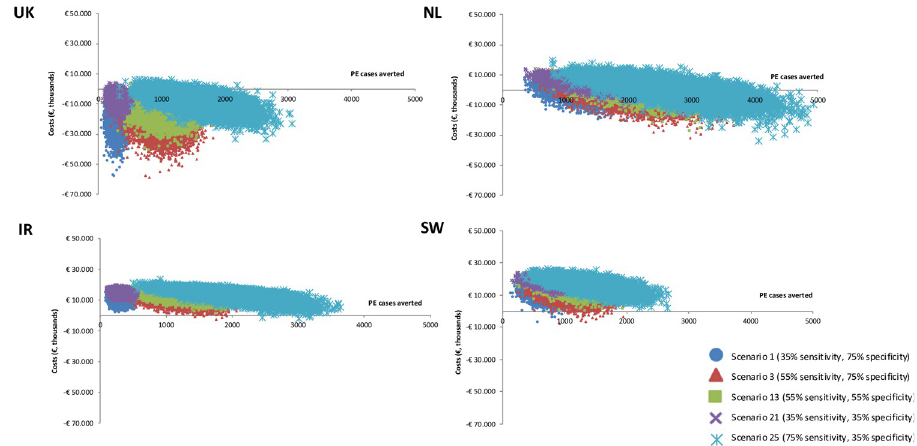
Fig 2. Cost-effectiveness planes of the new screening test for preeclampsia versus current screening strategy in base-case scenario analyses in four participating countries. UK: United Kingdom, NL: The Netherlands, IR: Ireland, SW: Sweden, PE: